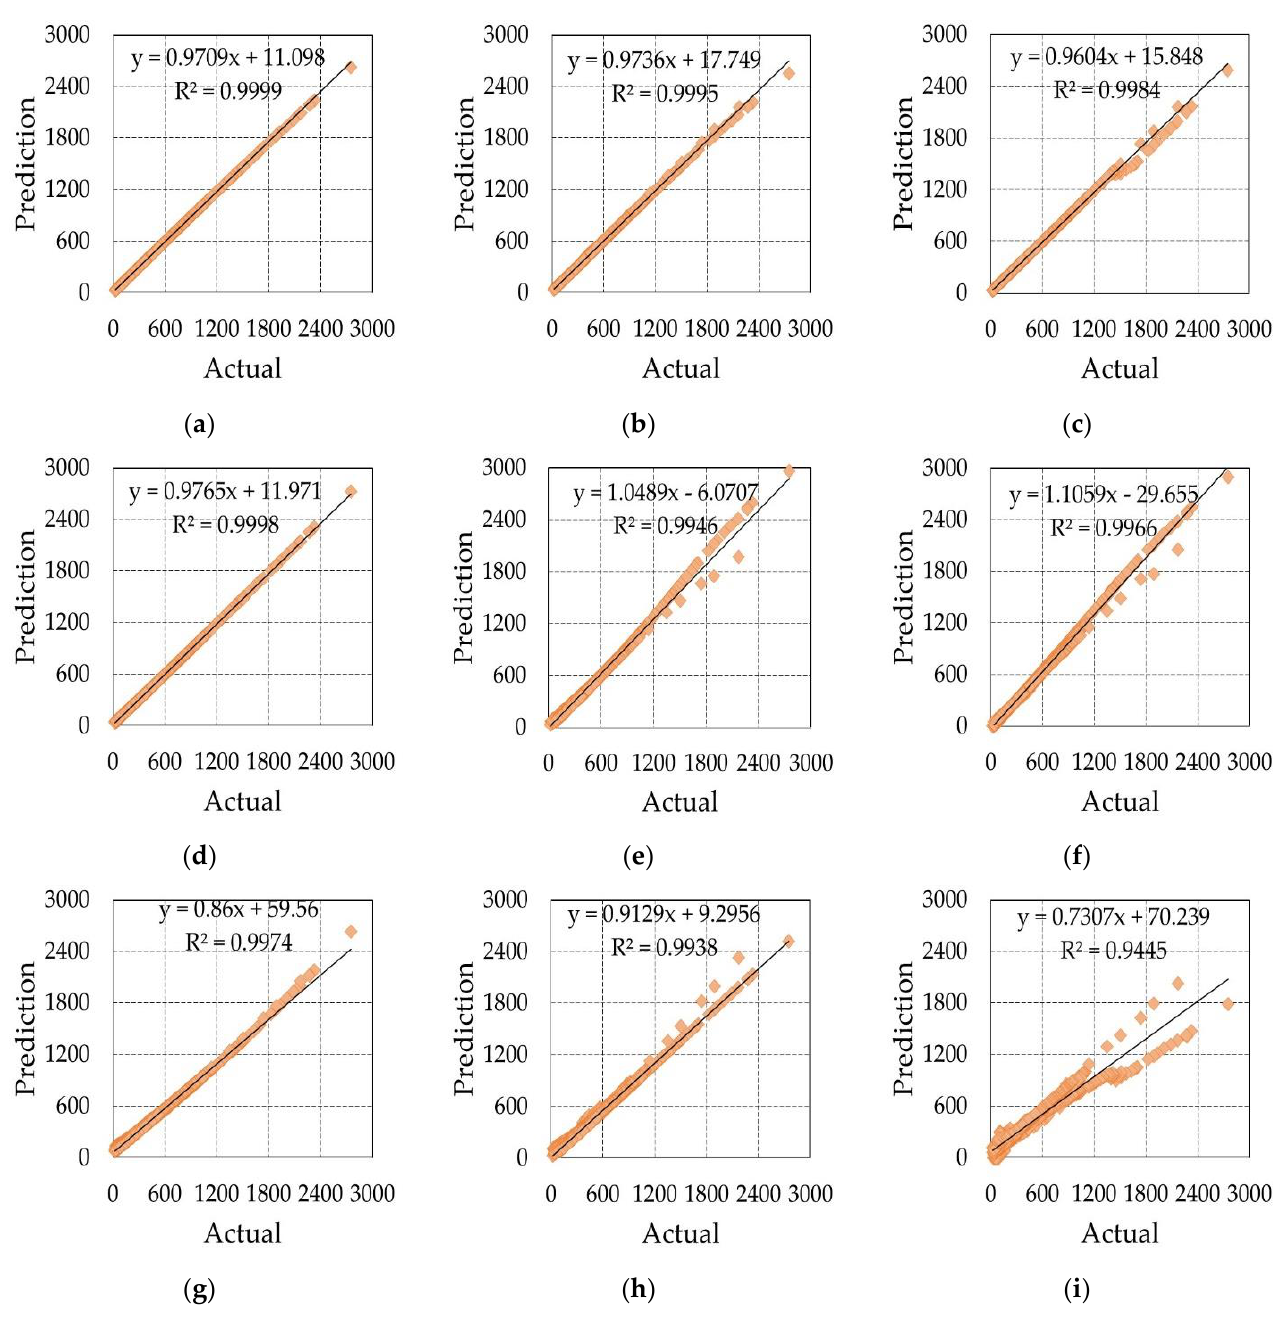
Figure 8. R 2 of prediction results of VOCs concentration. ( a ) LM-Hidden layer-1; ( b ) LM-Hidden layer-3; ( c ) LM-Hidden layer-5; ( d ) BR-Hidden layer-1; ( e ) BR-Hidden layer-3; ( f ) BR-Hidden layer-5; ( g ) BFG-Hidden layer-1; ( h ) BFG-Hidden layer-3; ( i ) BFG-Hidden layer-5.